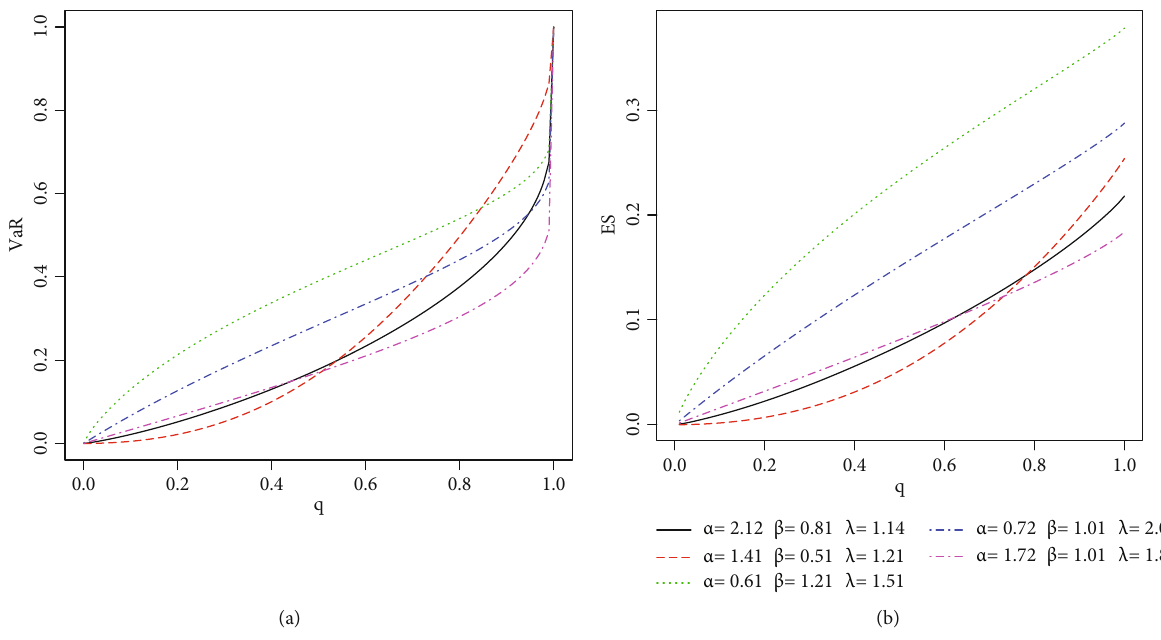
Figure 9: Plot of (a) VaR and (b) ES of UPWD for some parametric values.